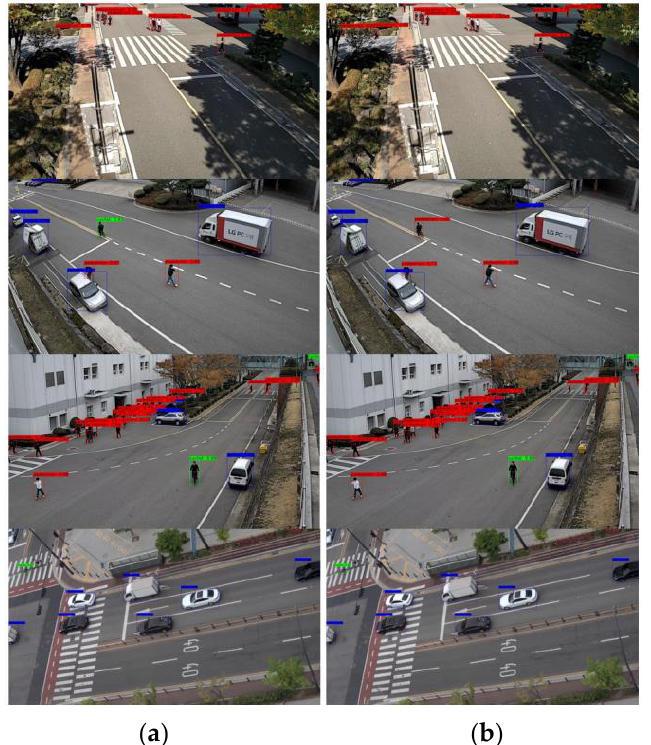
Figure 16. Detection results in SCOD. ( a ) Original version of YOLOv4; ( b ) YOLOv4 optimized for an edge